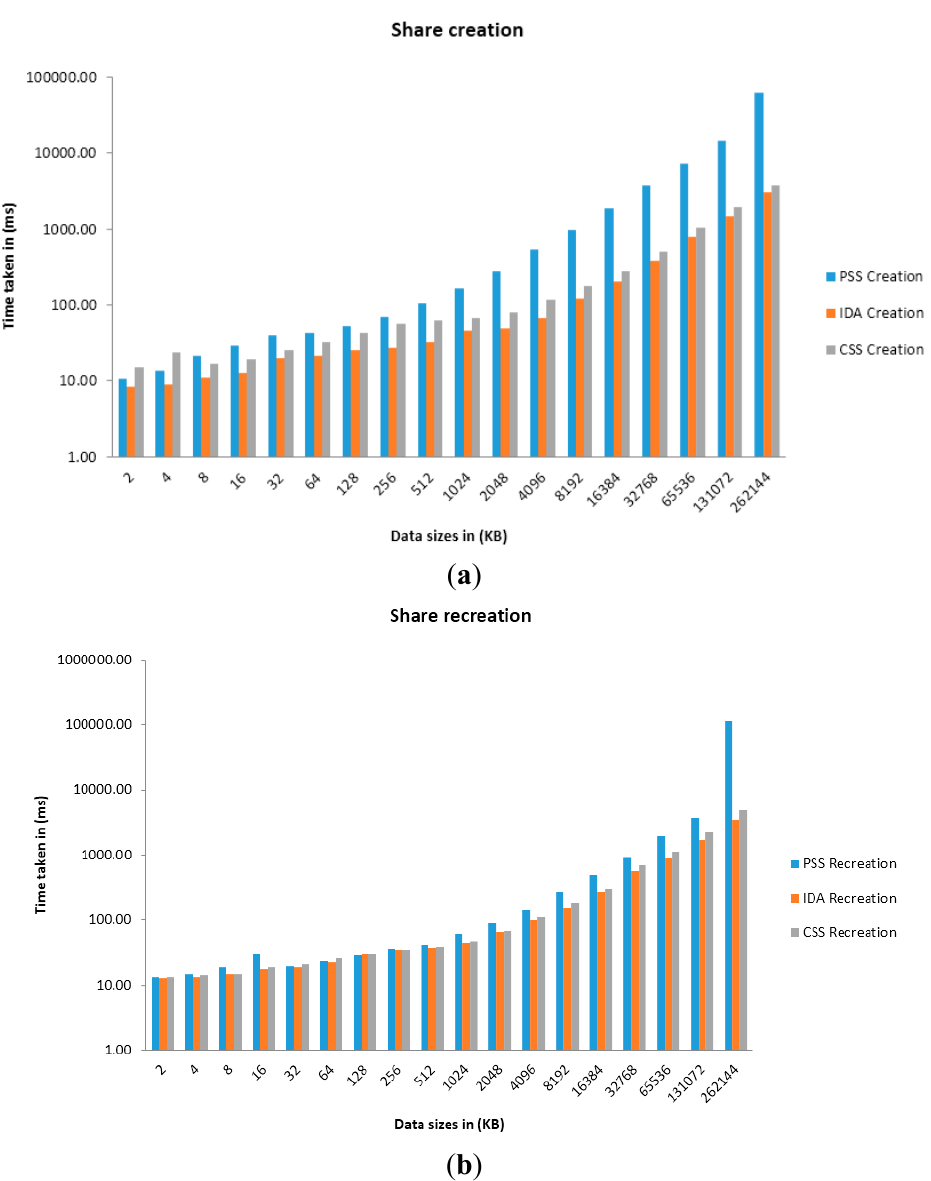
Figure 6. Graph of Time taken against Data sizes in share creation ( a ) and recreation ( b ) when n = 5, t =